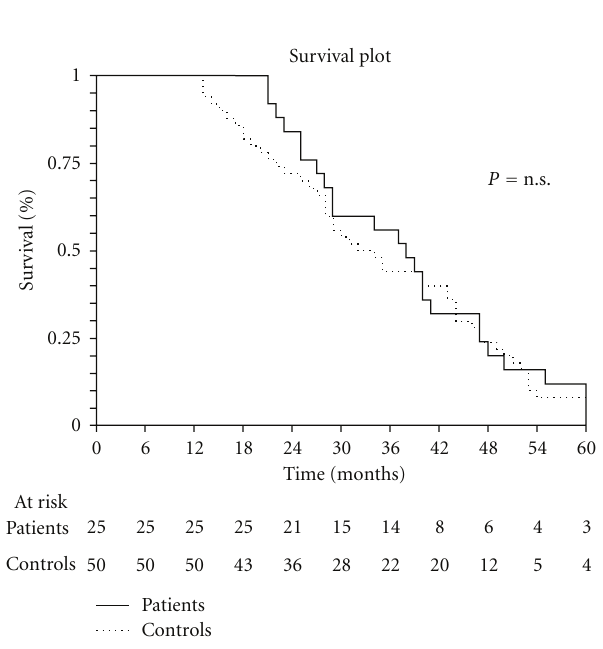
( P < 0 . 05, Table 4). The actuarial overall survival curves dis- (Figure 1) whereas the actuarial disease-free survival curves already show a significant di ff erence ( P < 0 . 01) between the two groups (36.8 months in the experimental group versus 21.9 months in the control group, Figure